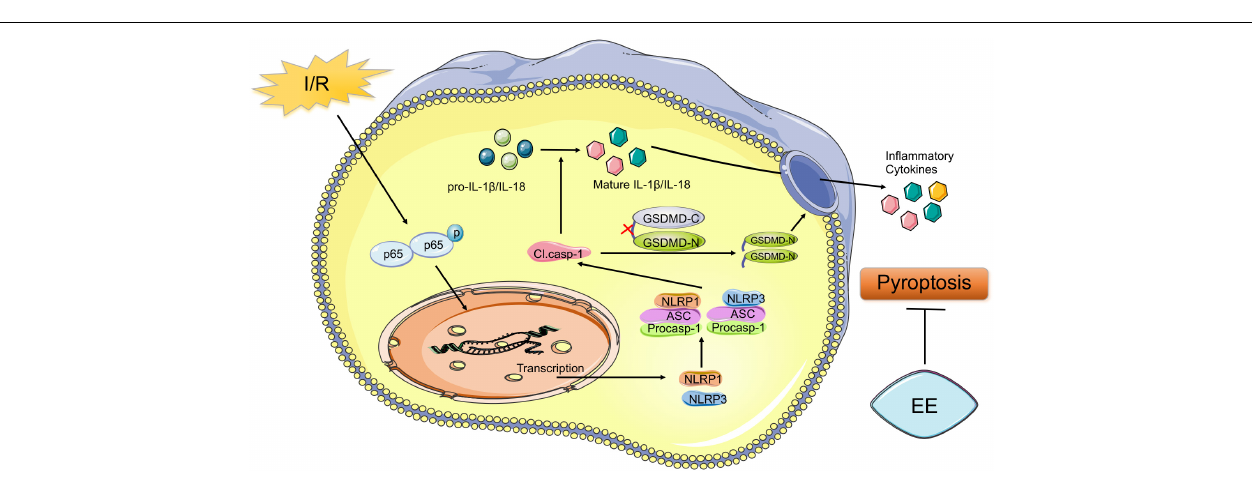
FIGURE 7 | Schematic mechanism of EE treatment regulates post-ischemic pyroptosis. The NF- κ B signaling pathway is activated following I/R injury, which stimulates the nucleus to induce transcription of NLRP1 and NLRP3 proteins to form the NLRP1 and NLRP3 inflammasome. Pro-caspase-1 is activated through NLRP1 and NLRP3 signal cleaving GSDMD into GSDMD-N and GSDMD-C. Then the pore-forming GSDMD-N domain causes membrane lysis inducing pyroptosis. Also, cleaved caspase-1 mediates the maturation of IL-1 β and IL-18 which are released into the extracellular environment. EE attenuates pyroptosis resulting in ischemic stroke outcomes